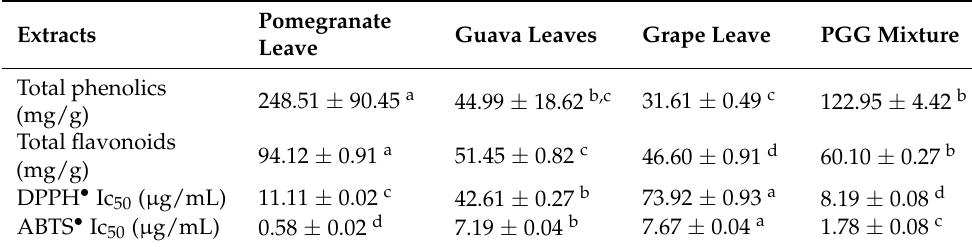
Table 2. Bioactive components and antioxidant activity of pomegranate leaves, guava leaves, grape leaves, and pomegranate-guava-grape (PGG) mixture leaves (1:1:1) extracts.